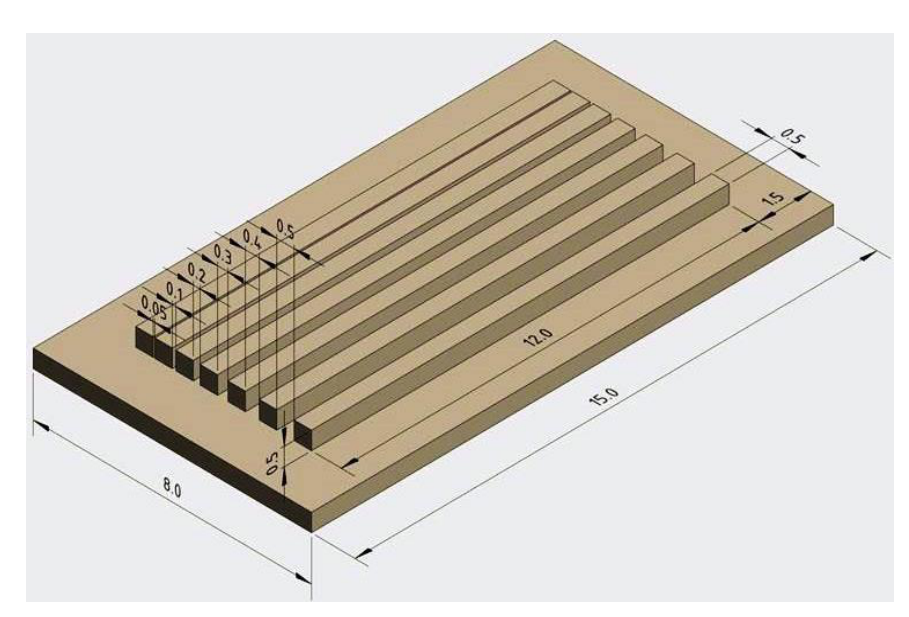
Figure 1. Design of the plate with channels (all dimensions in mm).